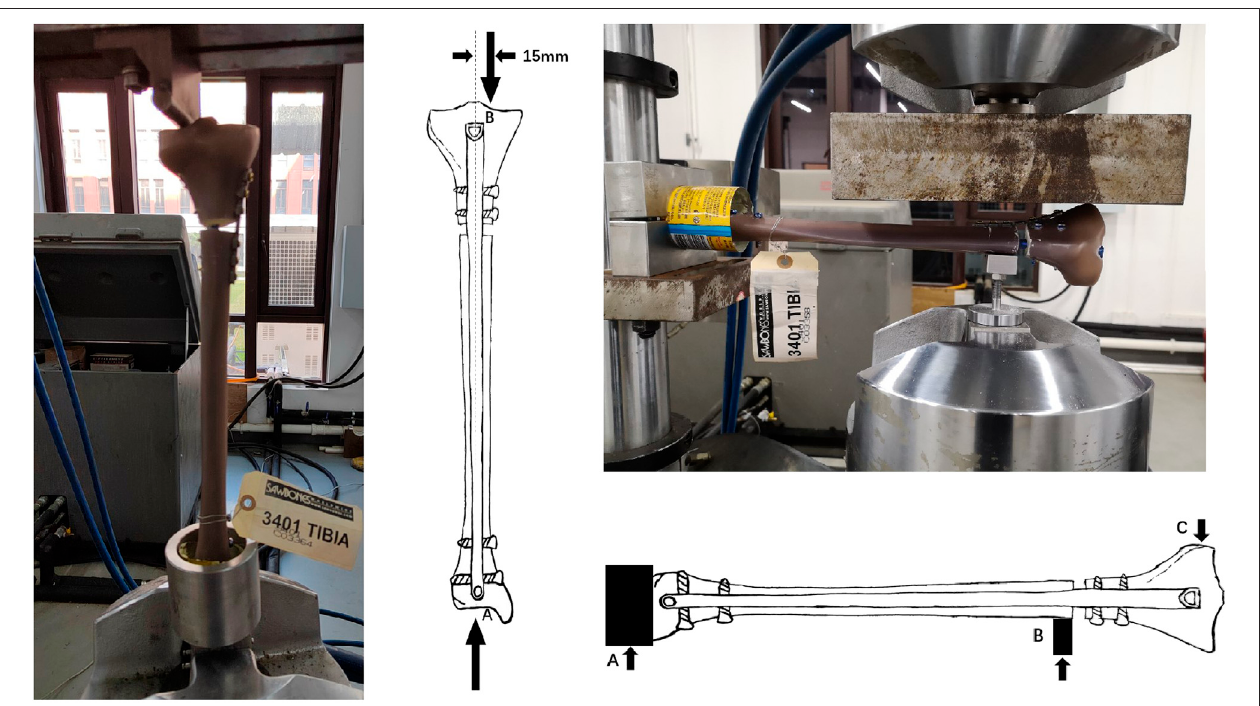
FIGURE 2 | Diagrammatic sketch of axial and bending load